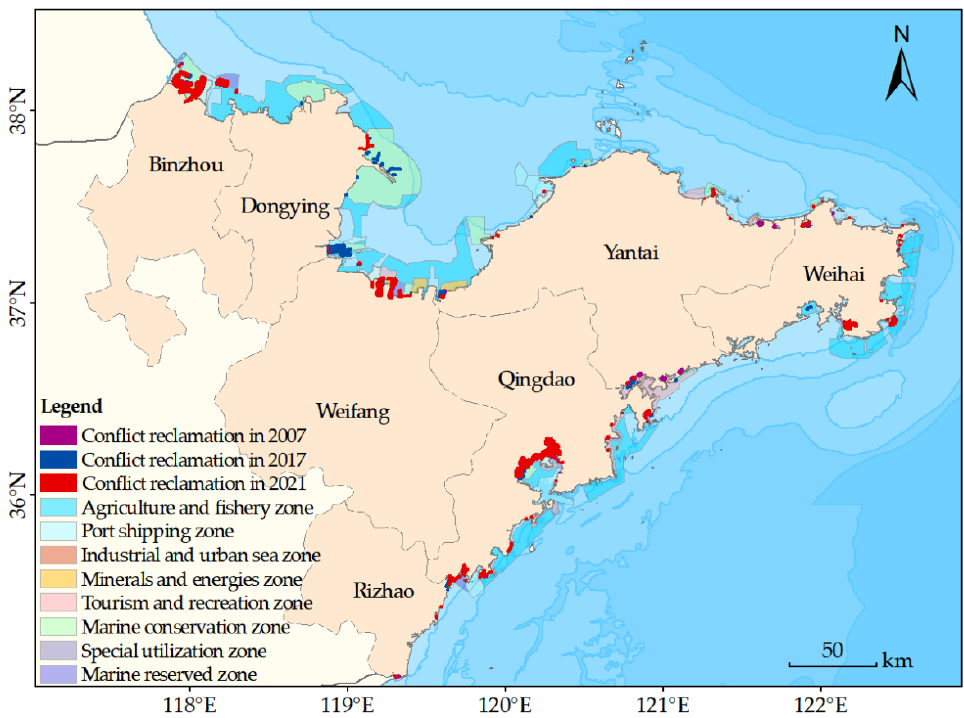
Figure 6. Distribution of conflict areas between reclamation activities and marine spatial planning. Table 5. Statistics on conflict ratio of reclamation activities in different marine spatial planning zones (Unit: %).